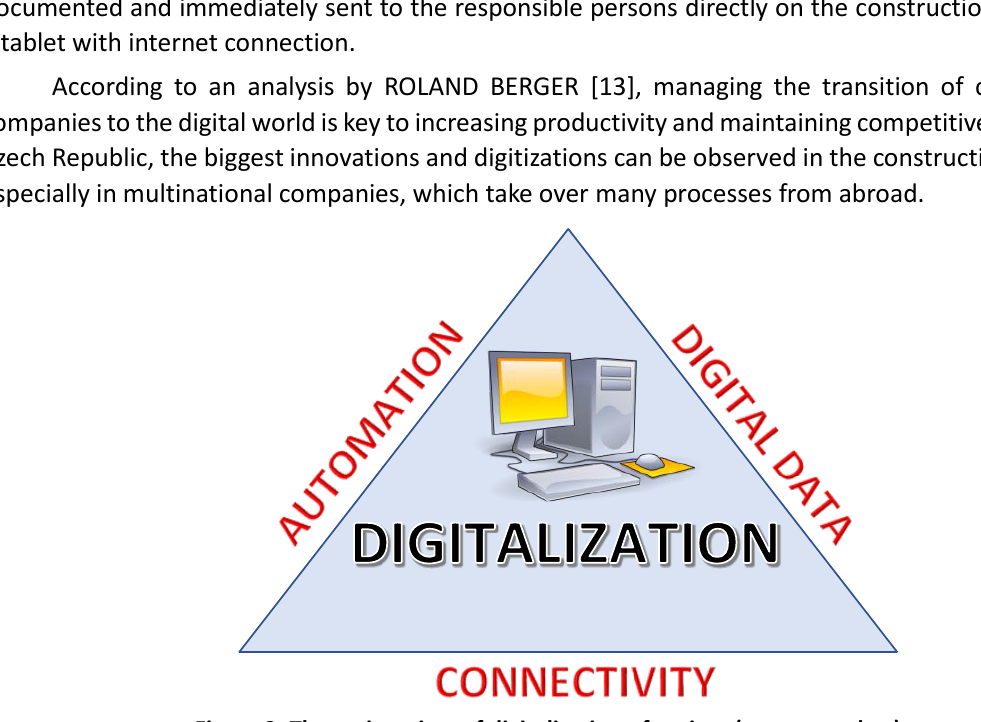
Figure 2: The main points of digitalization of society (source: